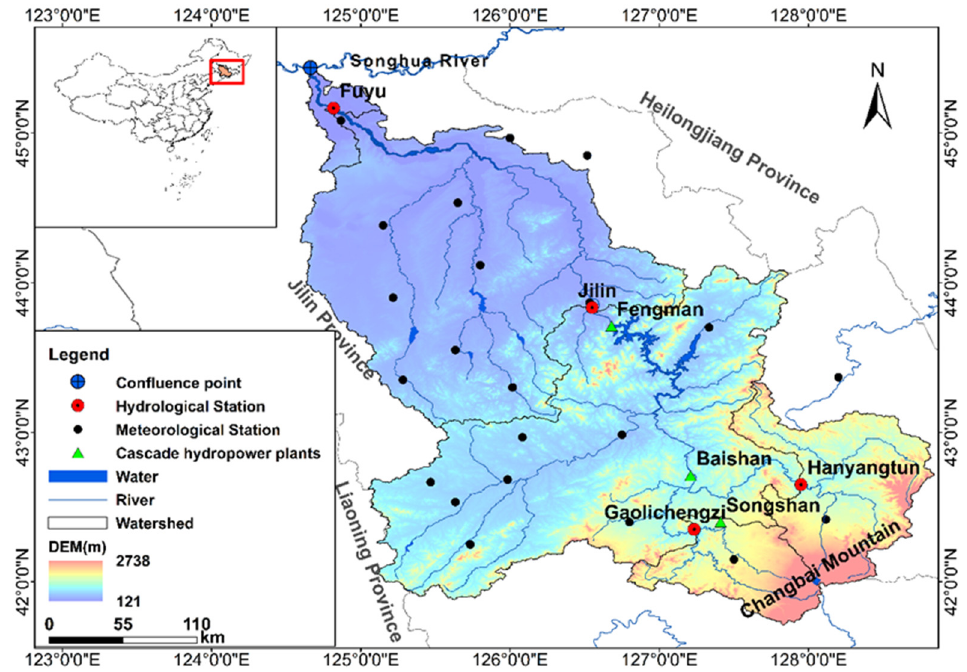
Figure 1. Locations of the SSR basin and hydro-meteorological